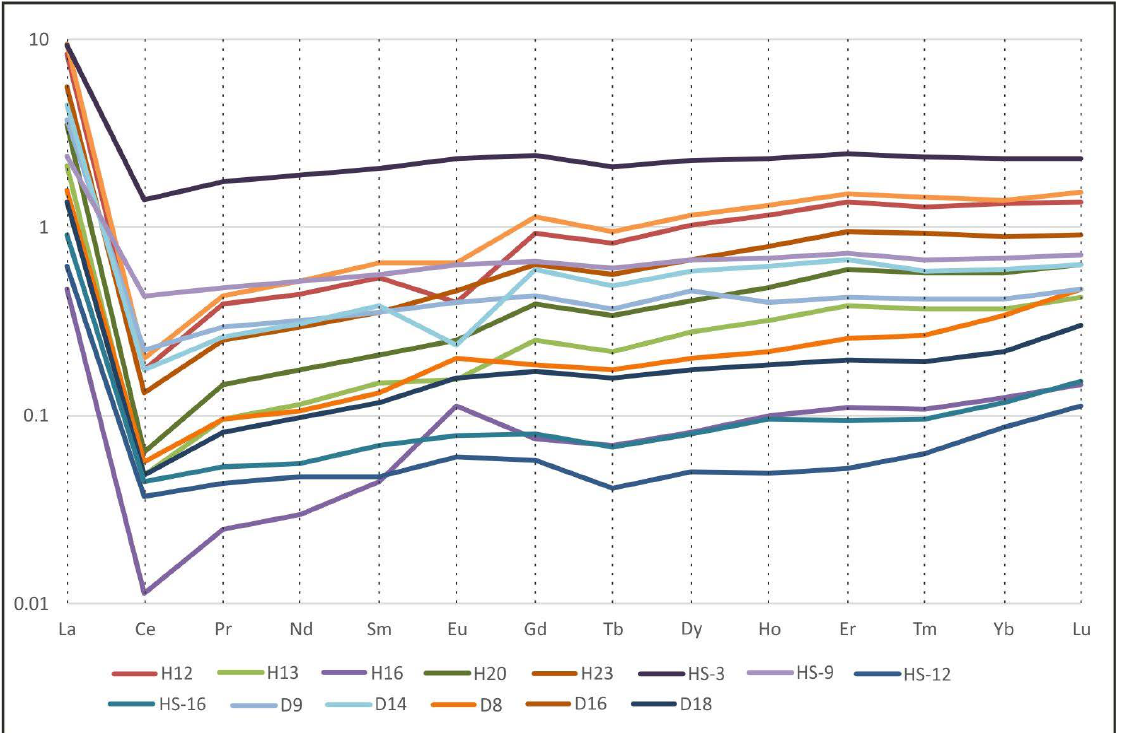
Figure 9. Rare earth element patterns normalized to post-Archaen Australian Shale (PAAS). Plotted samples were chosen to show the general pattern obtained from plotting the rare earth elements of the samples.